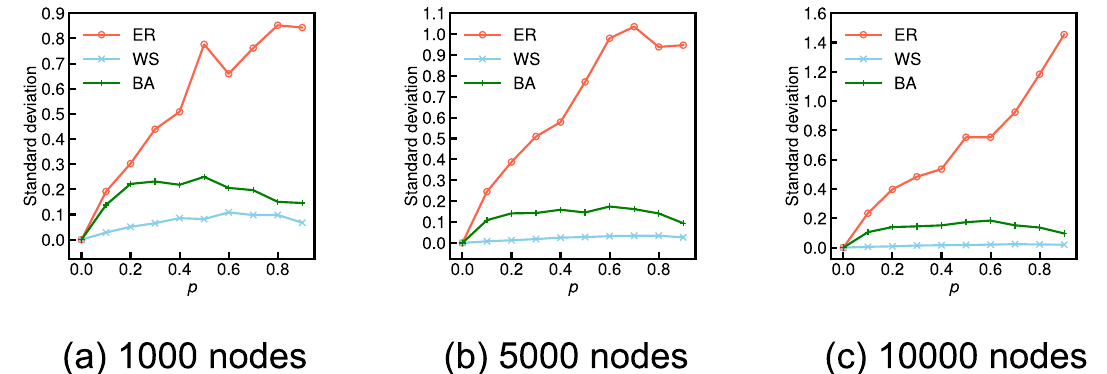
Figure 6. Comparison of the standard deviation of the relative network average clustering coefficients across 100 independent sets of randomly missing nodes with the probability p on ER, WS, and BA graphs for each 1000, 5000, and 10,000 nodes.